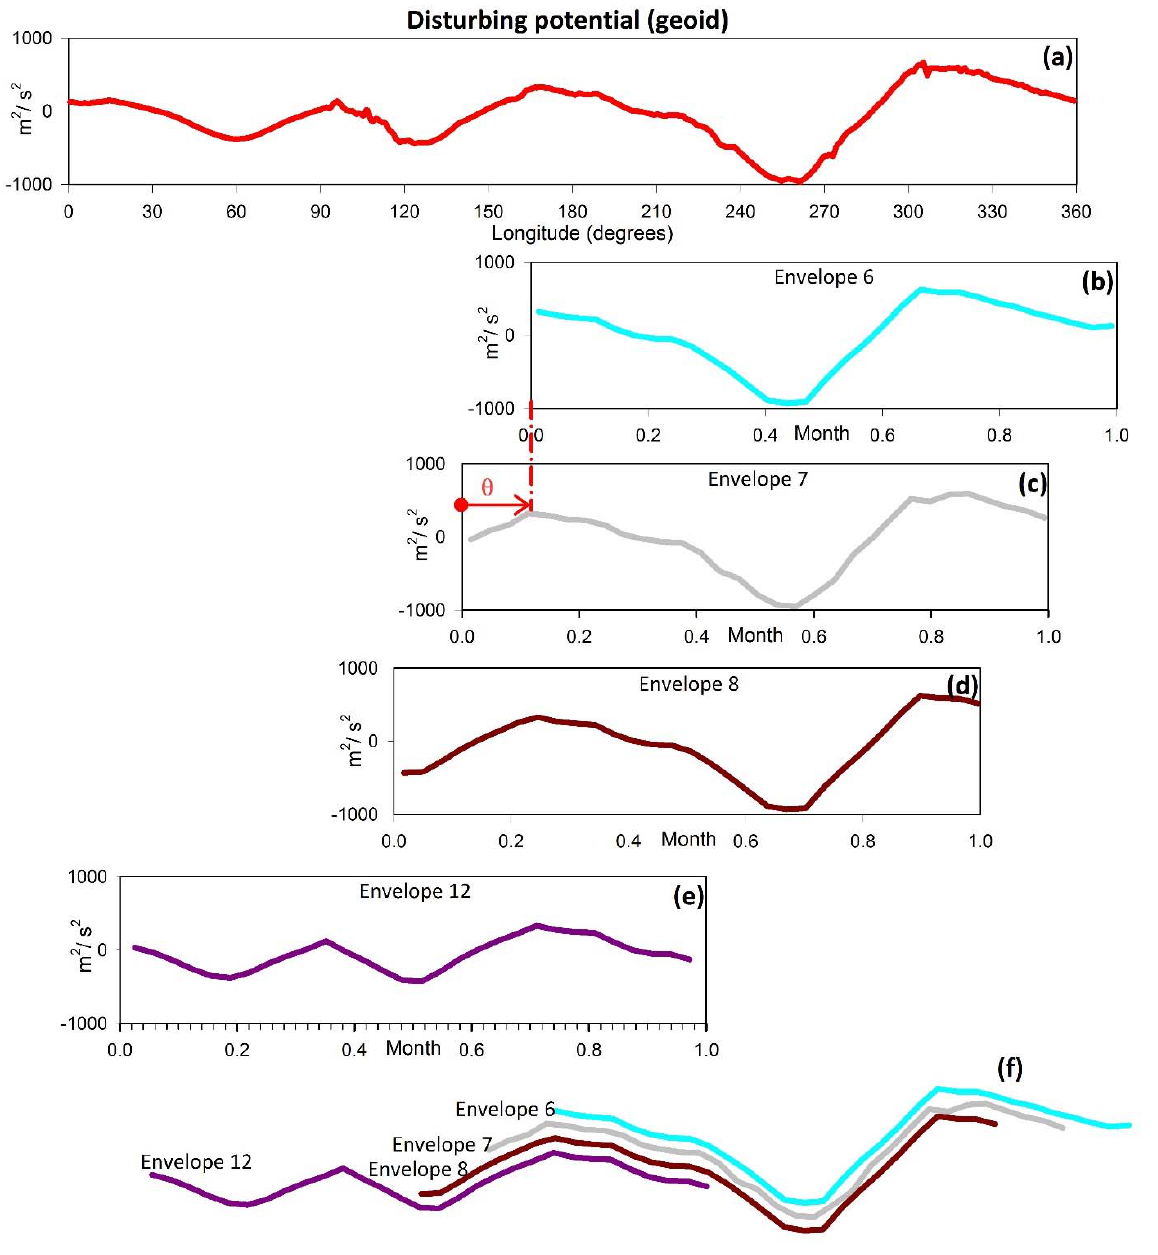
Figure 5. The disturbing potential (sampled signal; panel ( a )) and a collection of four contracted envelopes exemplifying that they are replicas of the disturbing potential. Panels ( b – d ) show the phase shift of successive modulating envelops by θ = 1/ f mod = 0.116, whereas panel ( e ) was randomly selected to show that is shifted by 4 θ w.r.t. envelope 8. Panel ( f ) shows graphically the modulating envelopes and their nearly perfect shape matching after been shifted.